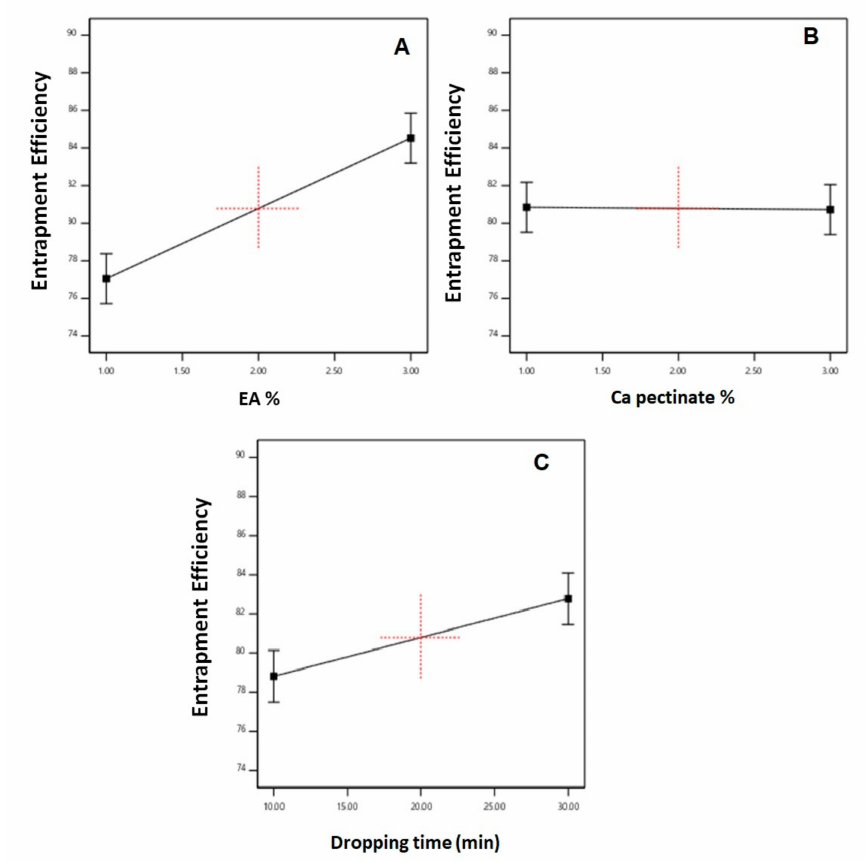
Figure 3. Main e ff ects of ( A ) ellagic acid % (X 1 ), ( B ) Ca pectinate % (X 2 ) and ( C ) dropping time (X 3 ) on ellagic acid entrapment e ffi ciency of EA–Ca pectinate floating